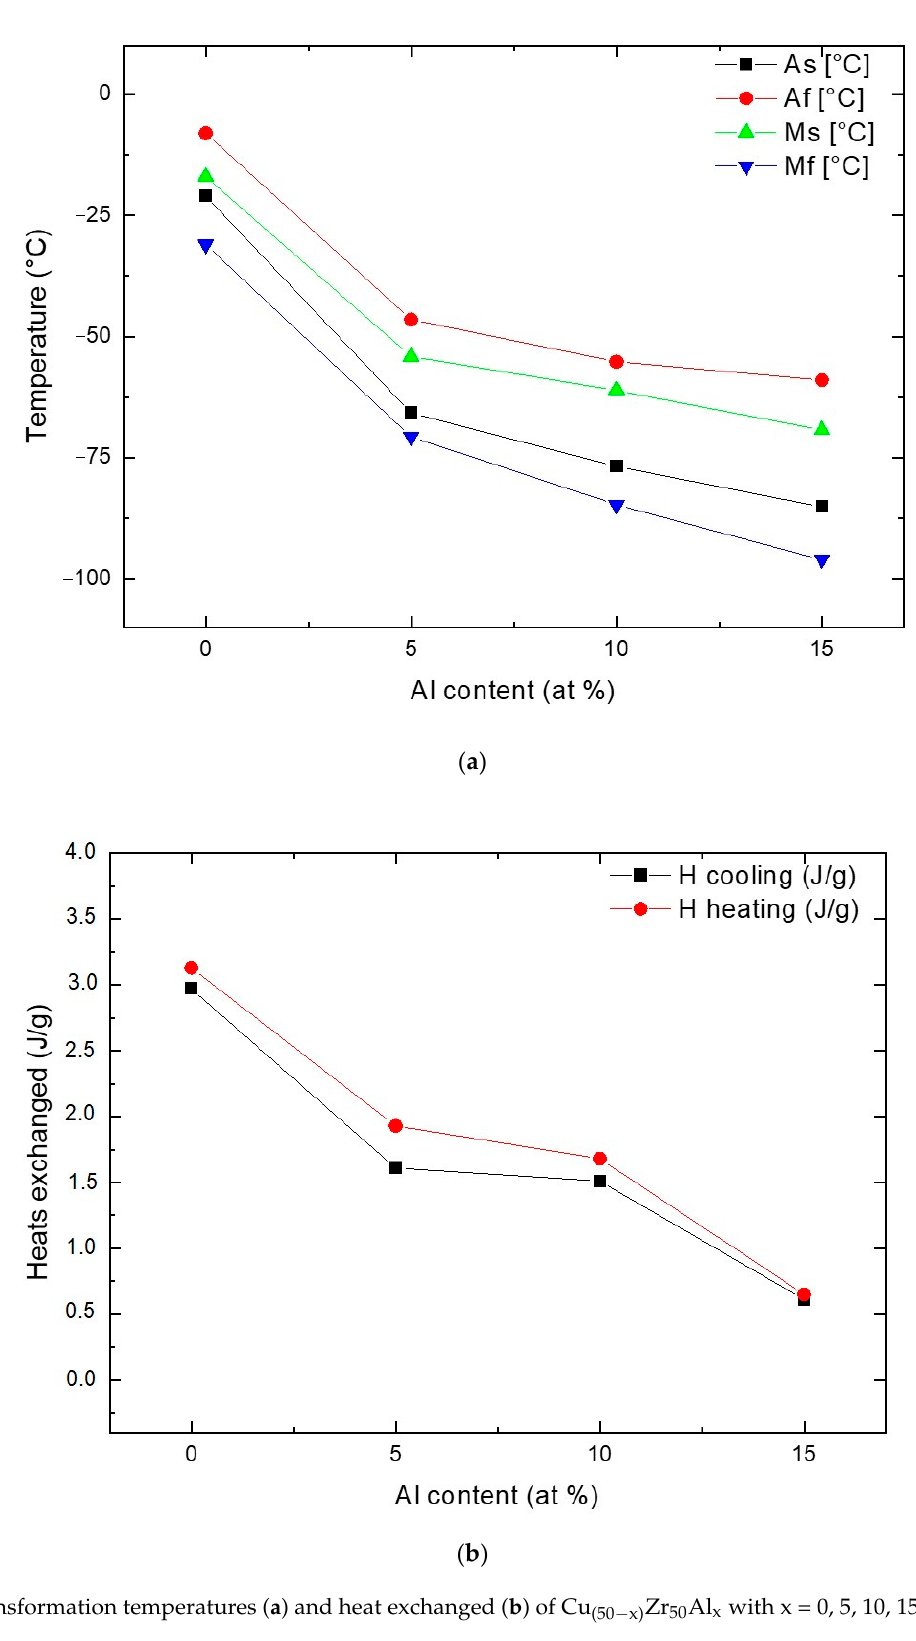
Figure 4. Transformation temperatures ( a ) and heat exchanged ( b ) of Cu (50 − x) Zr 50 Al x with x = 0, 5, 10, 15 at. % after MT stabilization.